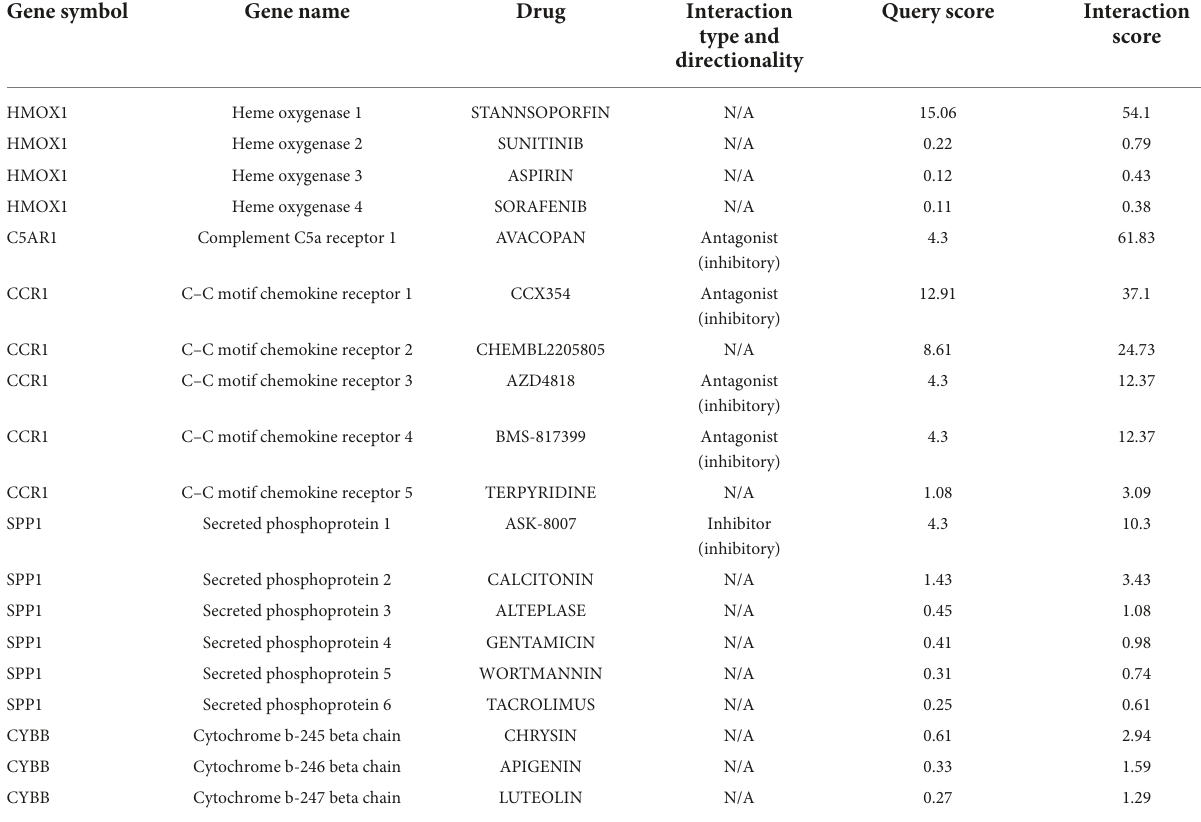
TABLE 4 Gene-drug interaction